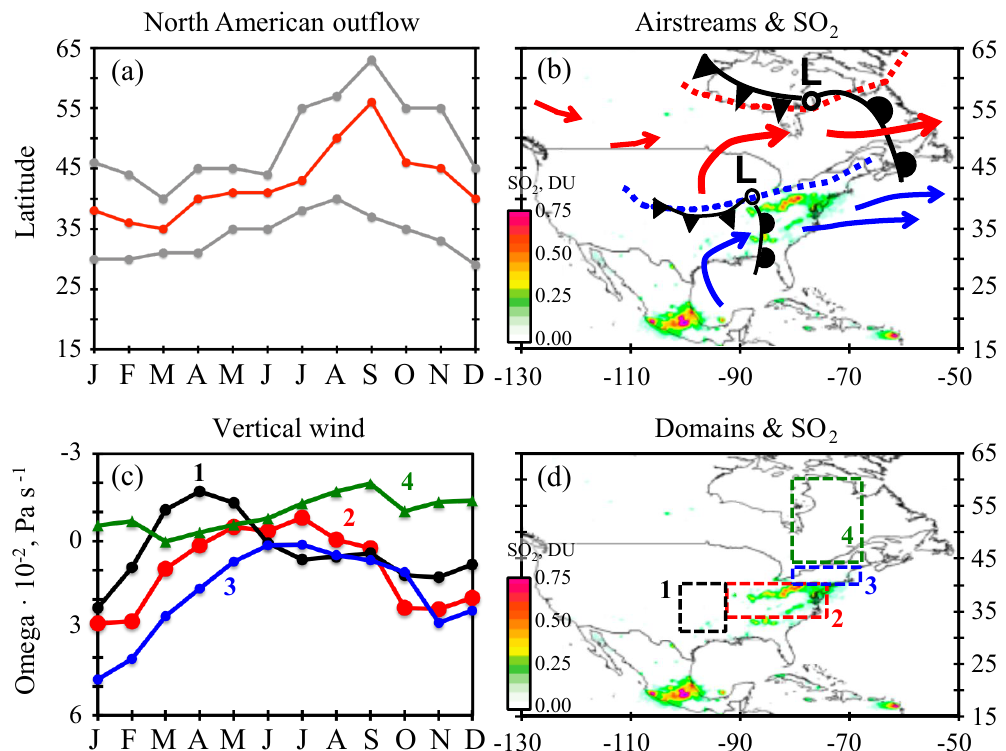
Figure 3. (a) Latitudinal ranges at which the westerlies occurs over the eastern coast of North America. Grey circles: maximum and minimum latitude of the outflow. Red circles: centre of the outflow. (b) Meteorological scenarios associated with export of pollutants (according to Cooper et al., 2002a, b; Merrill and Moody, 1996) and circulations (blue: January–May, red: July–August) illustrated over mean SO 2 values observed by satellite by Fioletov et al. (2016) – copyright of the authors. (c) Monthly average values of the omega vertical wind component at the 850hPa level (negative values indicate upward movements) calculated for the domains illustrated in plot (d) . (d) Domains 1 (32–40 ◦